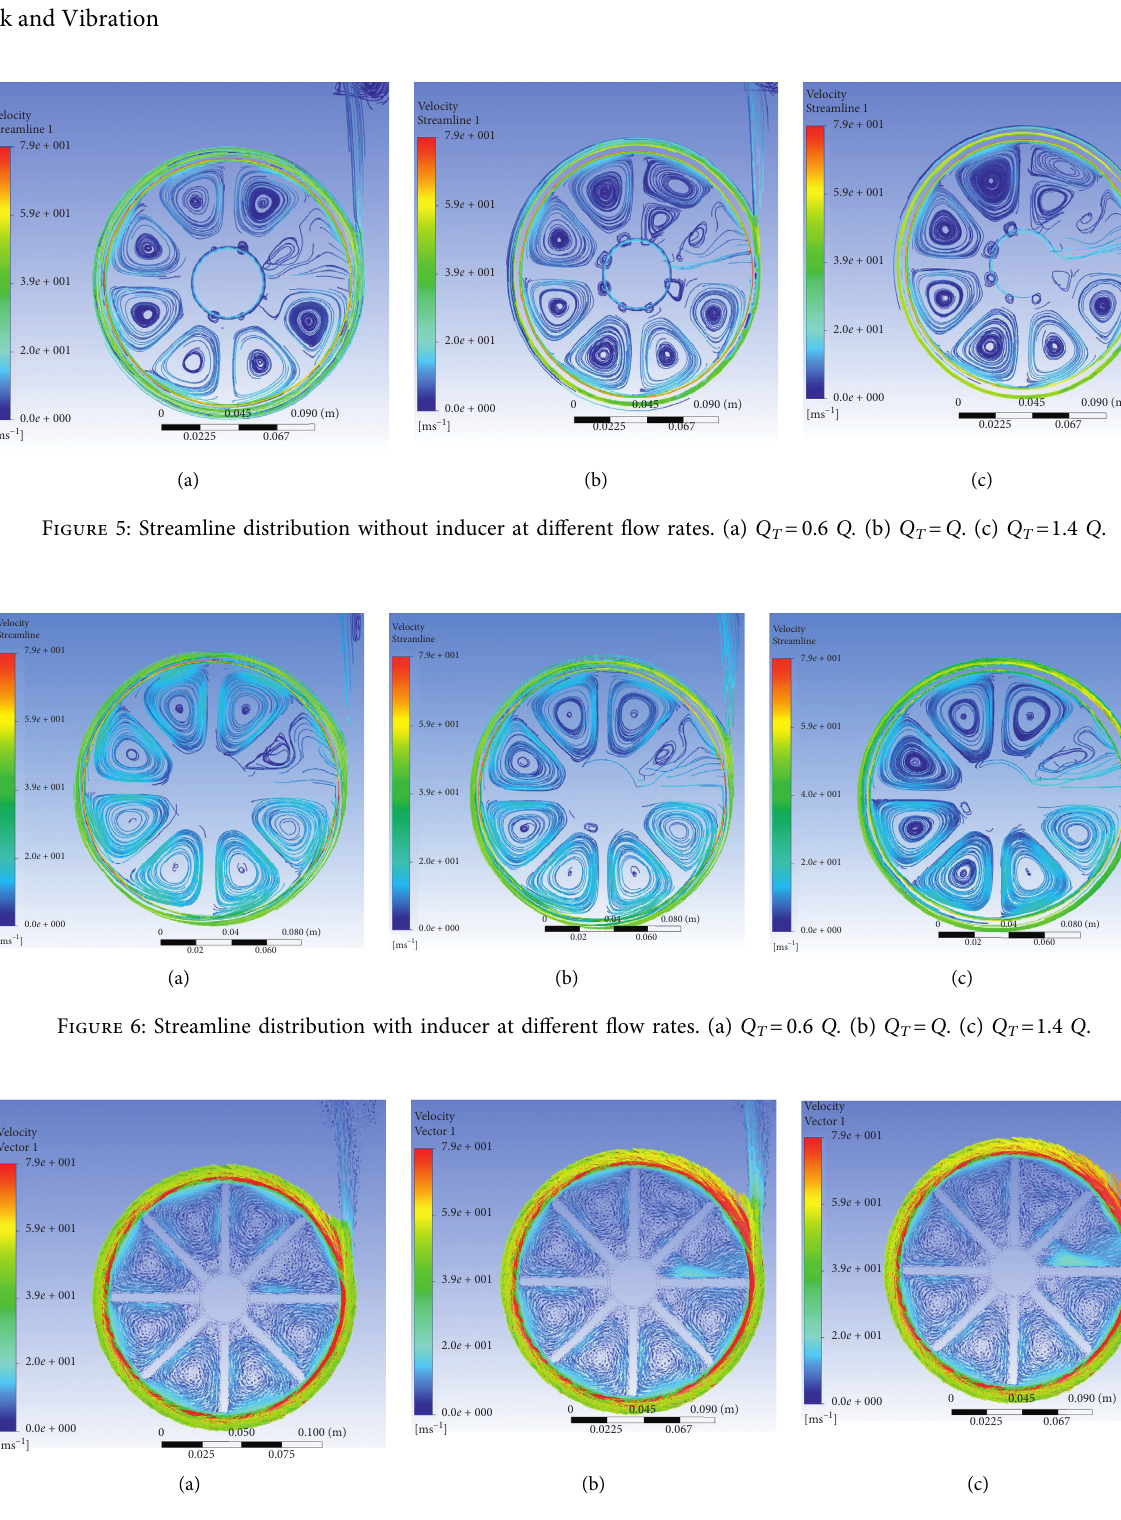
� 0.6 Q. (b) Q � Q . (c) Q � 1.4 Q T T T